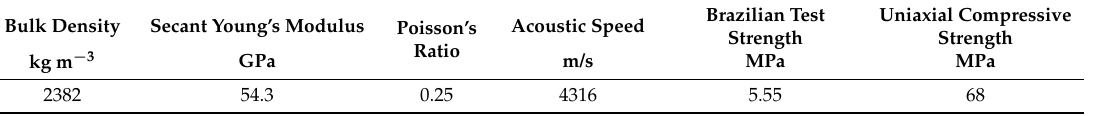
Table 1. The sandstone rock core dimensions were: ϕ 50 × 50 mm. Table 1. The physical and mechanical properties of the sandstone sample.